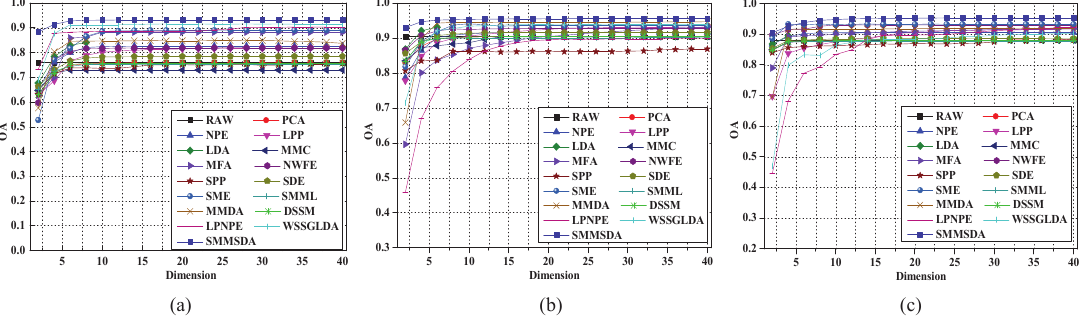
Figure 7. OAs with different embedding dimensions d . ( a ) PaviaU. ( b ) Heihe. ( c ) Washington DC